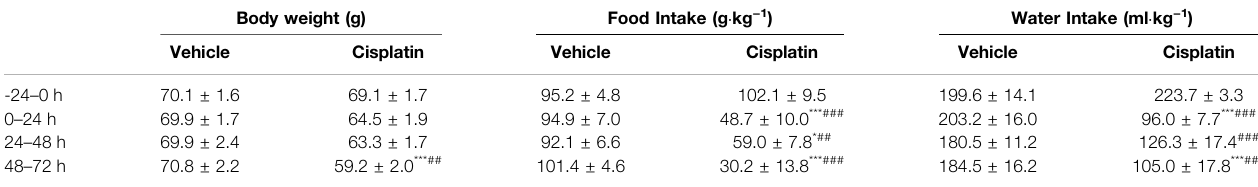
TABLE 3 | Effect of vehicle or cisplatin (30 mg/kg, intraperitoneal) on the body weight and food and water intake of Suncus murinus